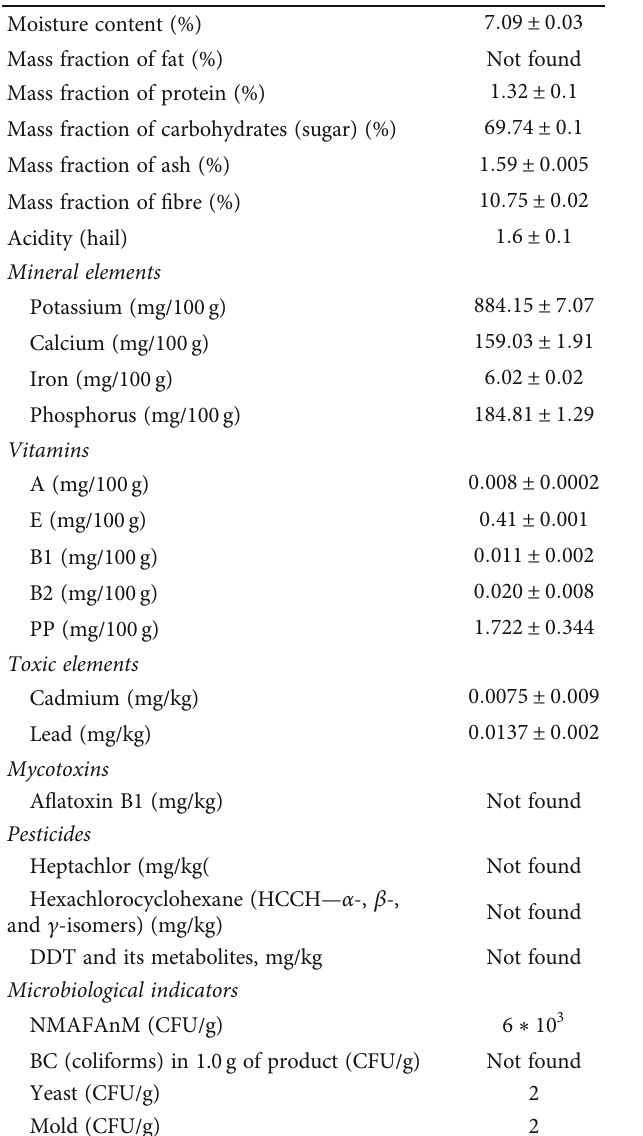
Table 4: Physicochemical and microbiological parameters of dry sugar beet powder. Name of indicators, units of